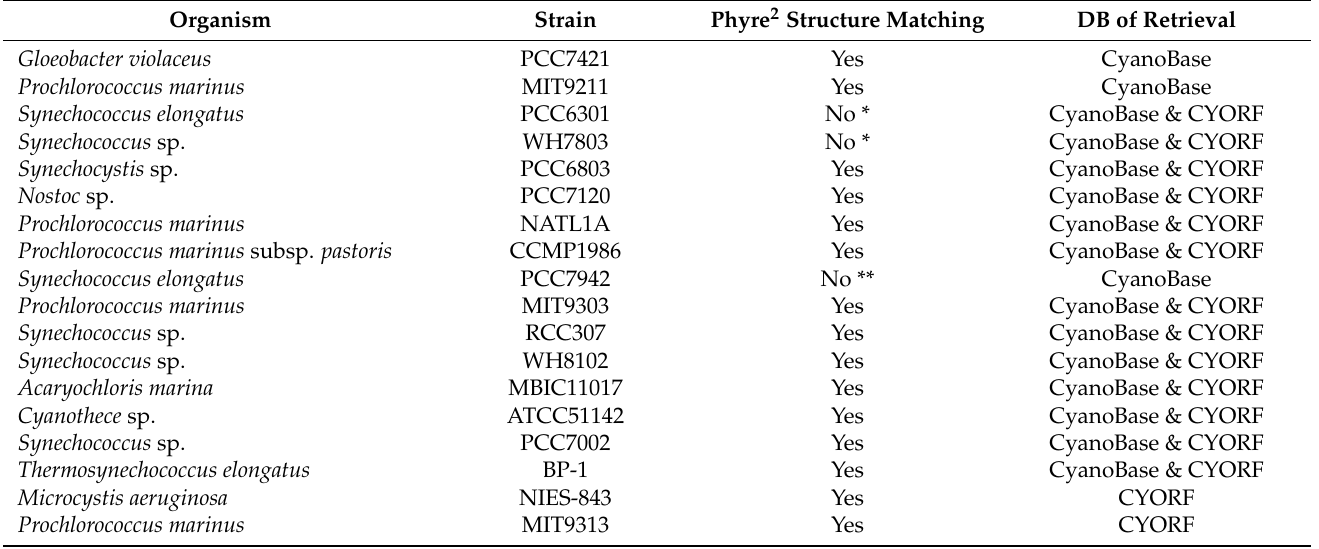
Table 1. Cyt c M protein sequences retrieved from CyanoBase and/or CYORF.